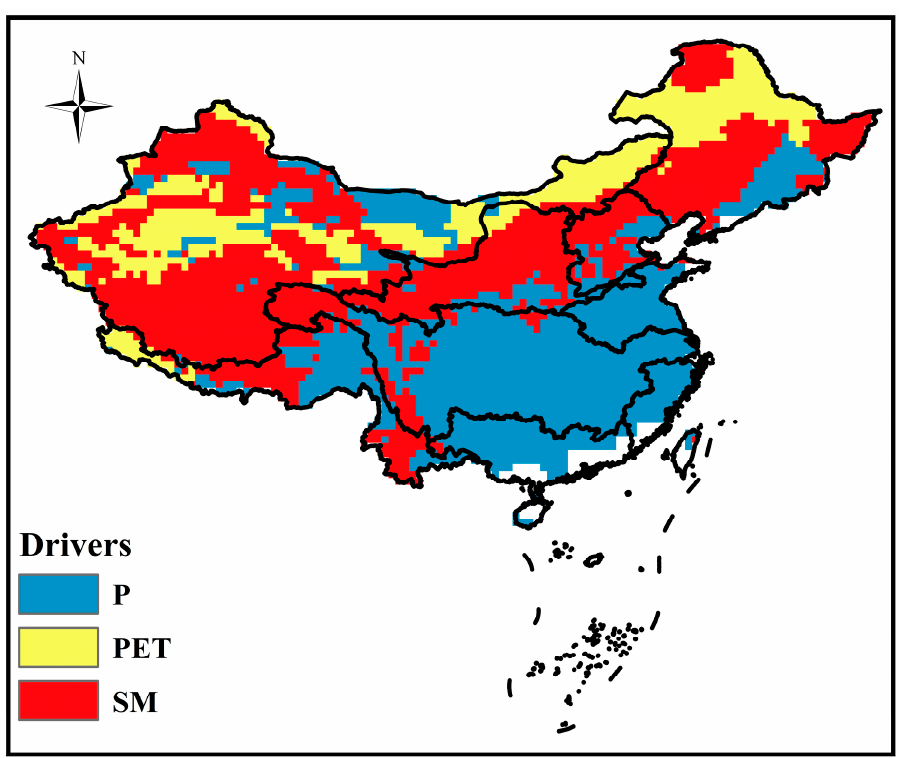
Figure 6. The primary driving factor of propagation from meteorological to hydrological drought in China. The drivers included P, PET, and SM.